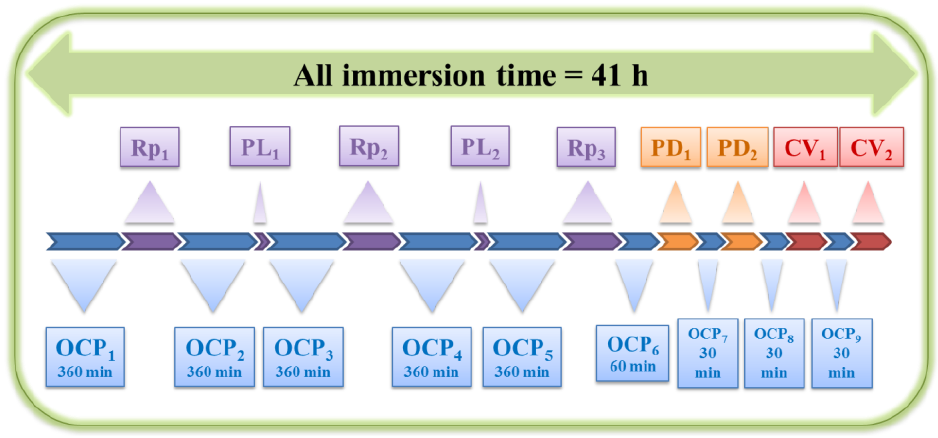
Figure 1. Schematic of the Zr2.5Nb alloy electrochemical corrosion assessment protocol in Ringer’s solution, staged according to the order and time required for each measurement.